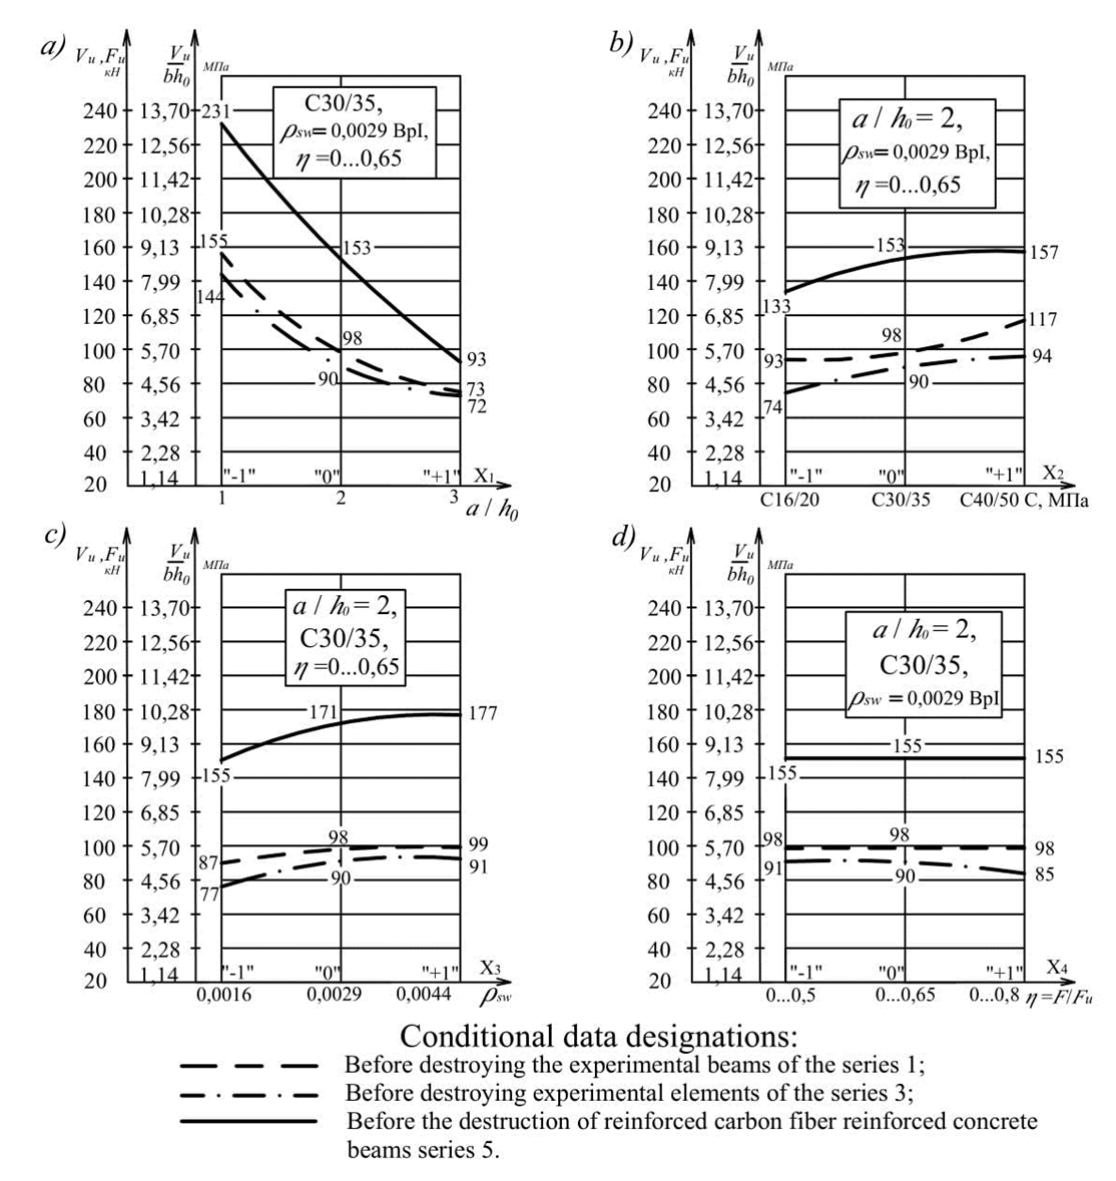
Figure 2. Destructive transverse force Vu or transverse loading (Fu) of the tested sample beams prior to their failure vs the value of the relative shear span а /h ( а ), concrete 0 grade С (b), quantity of the transverse reinforcement ρ (c) and level of the low-cycle sw repeated loading ɳ